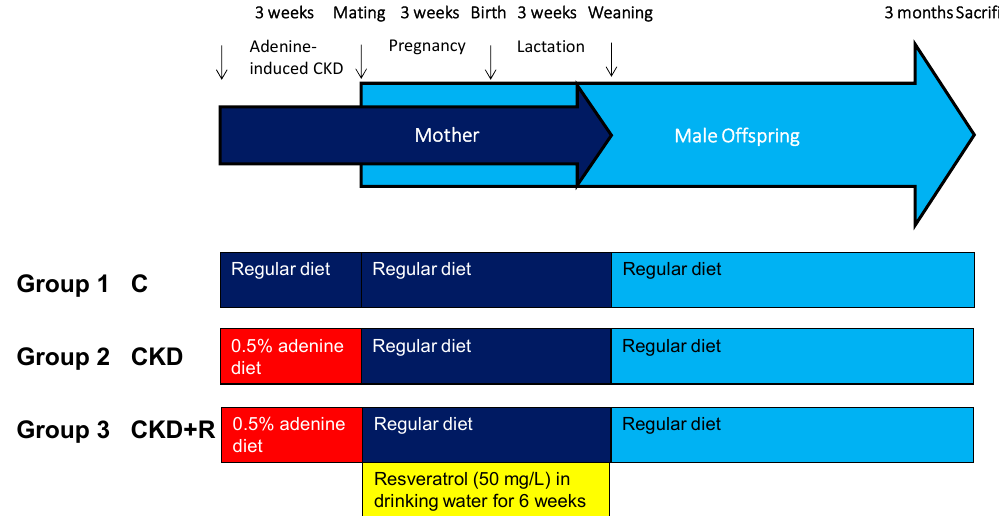
Figure 1. Schematic illustration of study design to establish a maternal adenine-induced chronic kidney disease (CKD) and/or resveratrol (R)-treated rat model to evaluate the protective effects of perinatal resveratrol therapy in male offspring at 3 months of age. The arrows indicate the different stages of development.